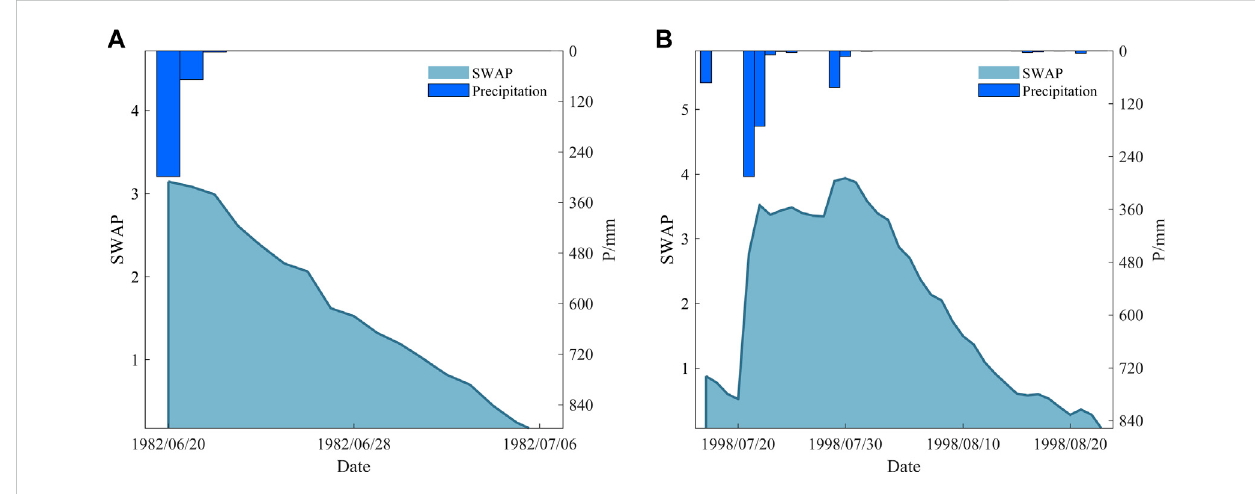
FIGURE 6 Relationships between SWAP and precipitation during rainstorm fl ood events: (A) 1982 and (B) 1998.